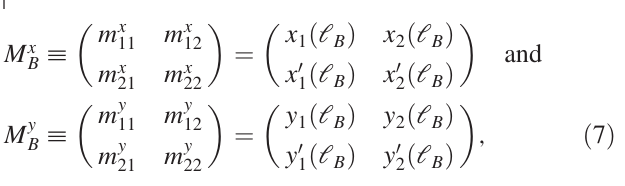
FIG. 10. Upper: Stable regions in the parameter space. Lower: Beta functions for x, y directions. Left is for ~ R ¼ 8 or V ¼ 1 MV) and right is for . 132 m ( B ρ ¼ 9 . 0 Tm or V ¼ 38 MV). Positions of QF, QD, and bending magnet are shown by the background color of red, blue, and green in the lower